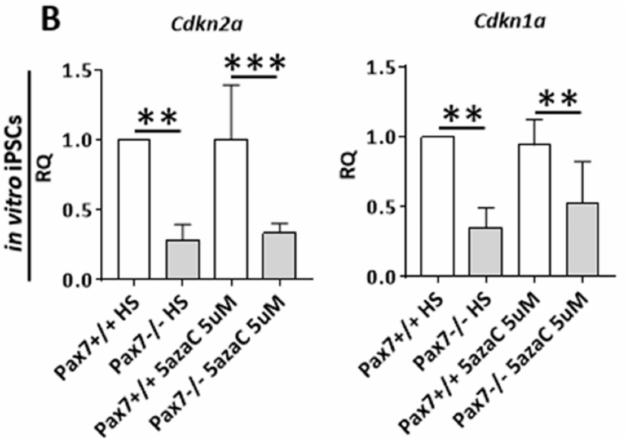
Figure 6. Cell cycle inhibitors in differentiating Pax7 +/+ and Pax7 − / − ESCs and iPSCs treated with HS and 5-azacytidine. ( A ) Expression of mRNAs encoding p16INK4A ( Cdkn2a ), p21CIP1 ( Cdkn1a ) in differentiating Pax7+/+ and Pax7 − / − ESCs treated with HS and 5azaC. ( B ) Expression of mRNAs encoding p16INK4A ( Cdkn2a ), p21CIP1 ( Cdkn1a ) in differentiating Pax7+/+ and Pax7 − / − iPSCs treated with HS and 5azaC. White bars—values for Pax7 +/+ ESCs and iPSCs; gray bars—values for Pax7 − / − ESCs and iPSCs. Expression was related to the levels observed in 13.5 d.p.c. mouse embryo (E13.5) and normalized to mRNA encoding β -actin ( Actb ). Data are presented as mean ± SD. Stars symbolize result of two-way ANOVA and post-hoc Sidak’s multiple comparisons test: ** p < 0.01, *** p < 0.001. Scale bar 100 µ